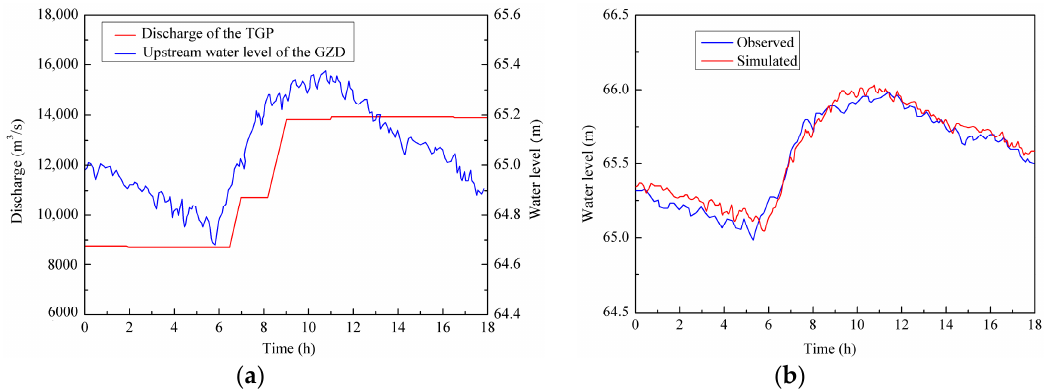
Figure 5. Boundary conditions and simulation results using a one-dimensional model. ( a ) Boundary conditions; ( b ) Comparison of the observed and simulated water level at the lower lock head of the ship lift.